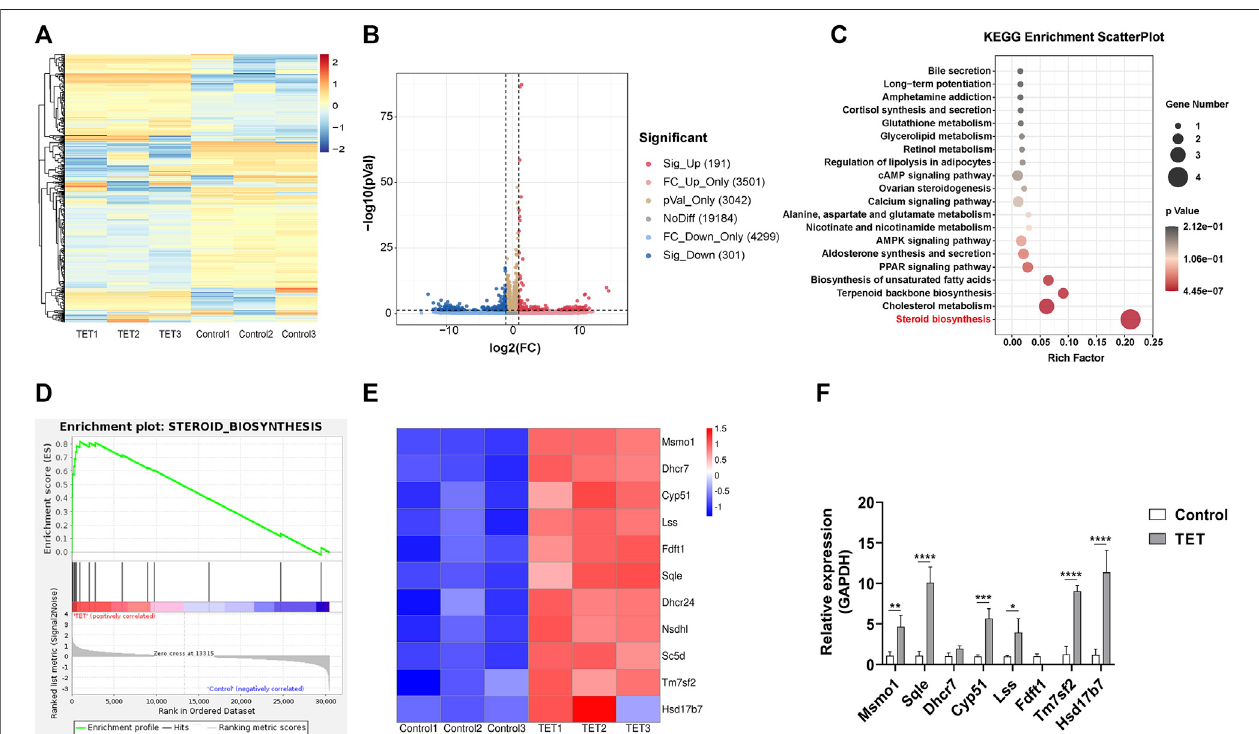
FIGURE 6 | TET promotes steroid biosynthesis in the cochlea (A) Heat map representation of signi fi cantly differentially expressed genes after TET treatment (B) Volcano plot representation of signi fi cantly differentially expressed genes after TET treatment (C) KEGG pathway enrichment analysis of the most signi fi cantly changed pathwaysafterTETtreatment (D) GSEAofgenesrelatedtosteroidbiosynthesisinthecontrolandTETtreatmentgroups (E) Heatmapofdifferentiallyexpressedgenesin the steroid biosynthesis pathway (F) Real-time PCR analysis of differentially expressed genes related to the steroid biosynthesis pathway (n = 3). * p < 0.05, ** p